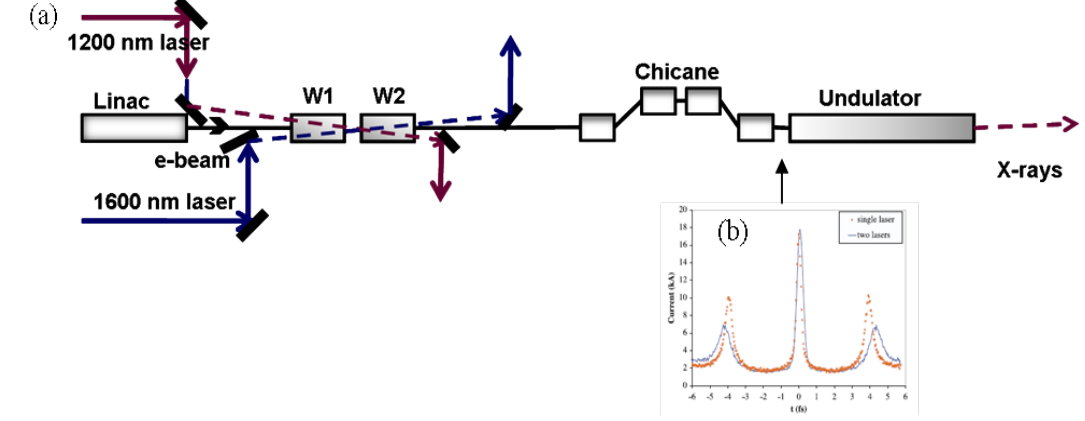
Figure 4. (Color online). Two-color ESASE scheme. ( a ) The layout of the scheme. ( b ) Current profiles of electron bunch after interaction with lasers; for two lasers (blue-line) and single laser (red-cross)